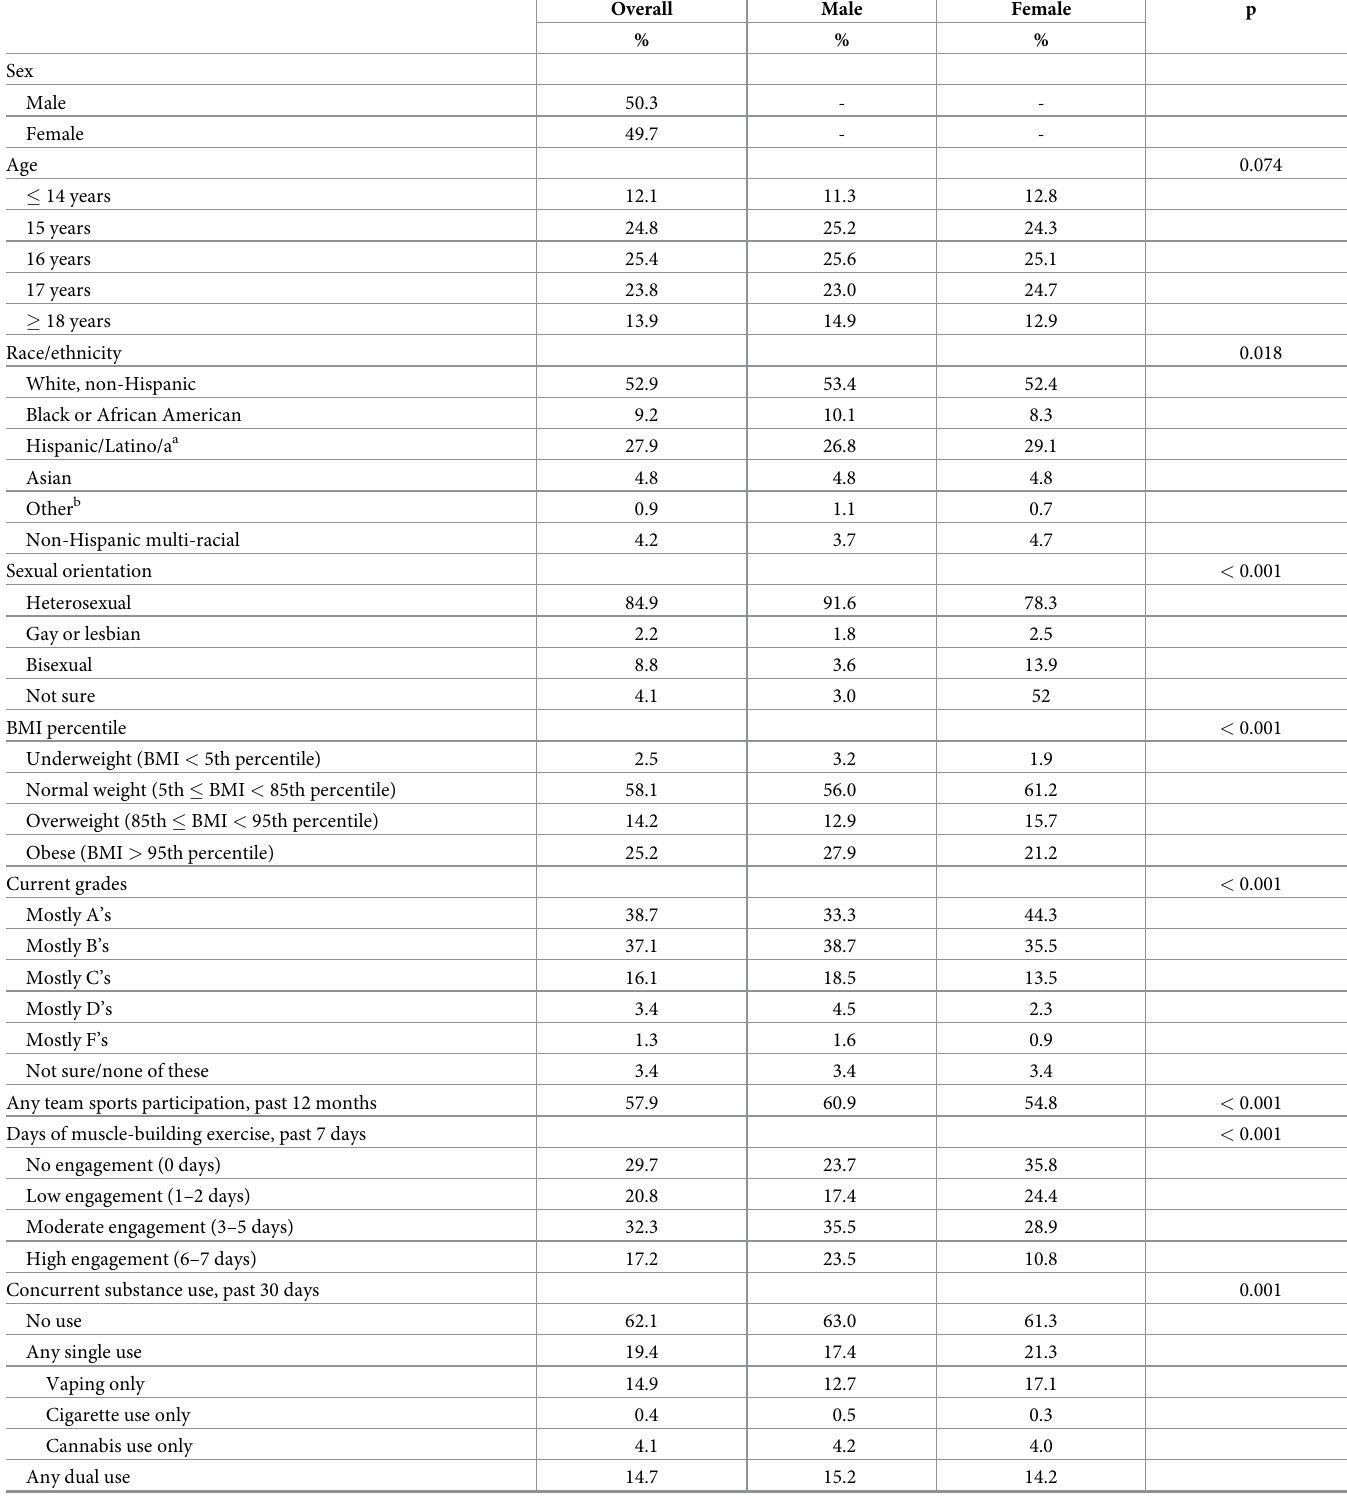
Overall Male Female